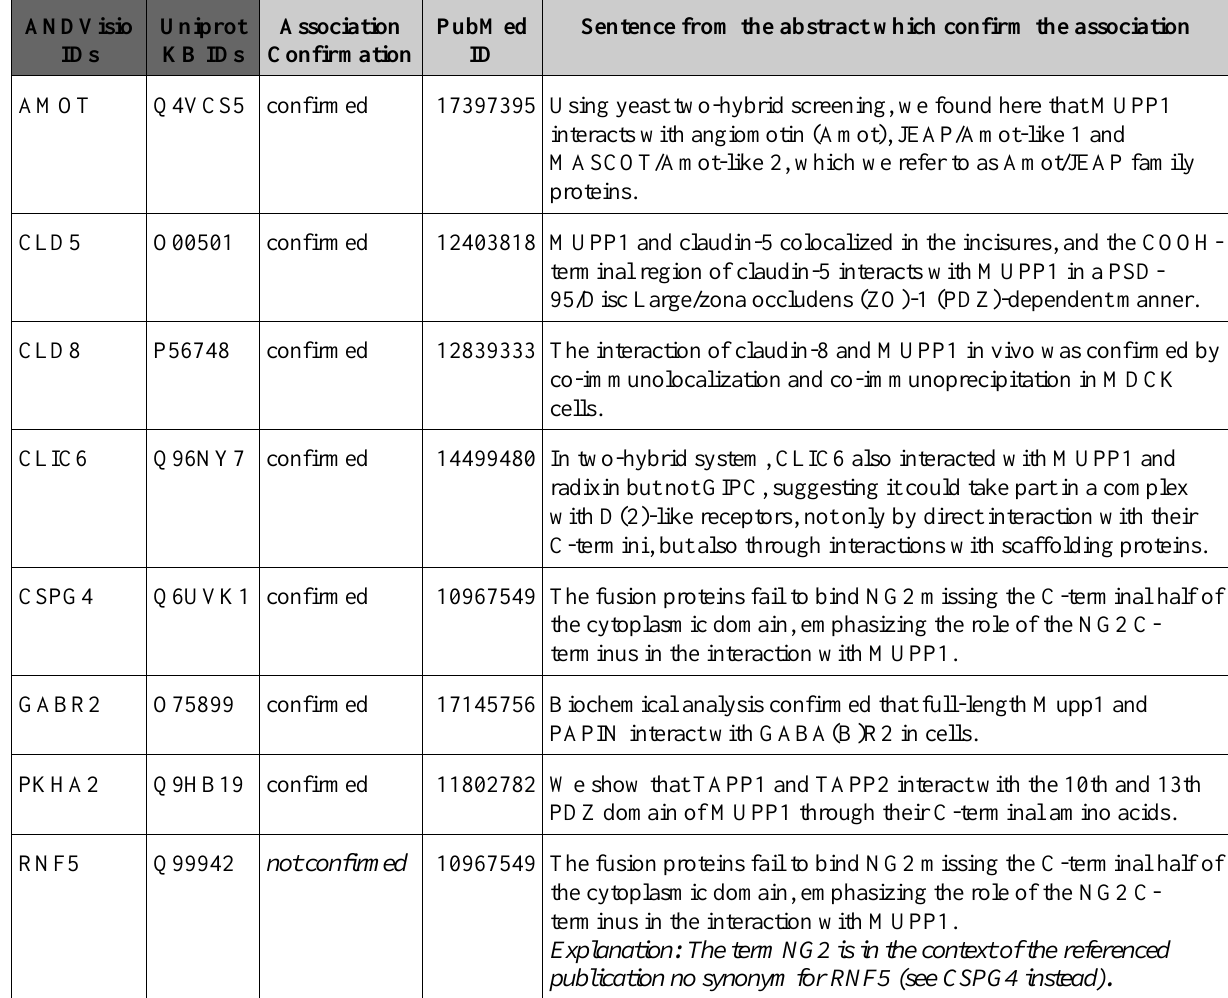
Table 1. Sentences from PubMed proving associations to MUPP1/MPDZ extracted by